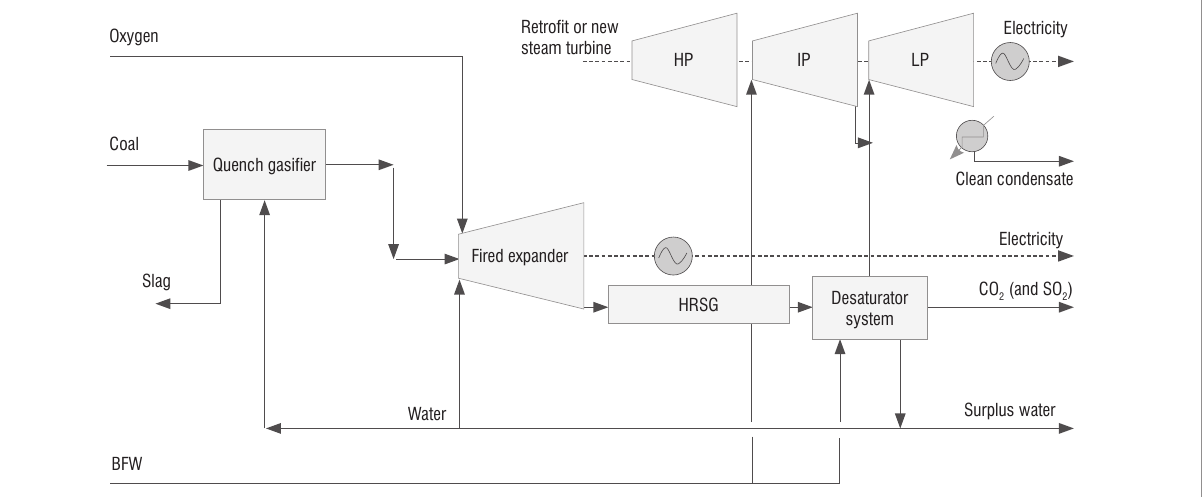
Figure 15: Integrated gasification steam cycle process.